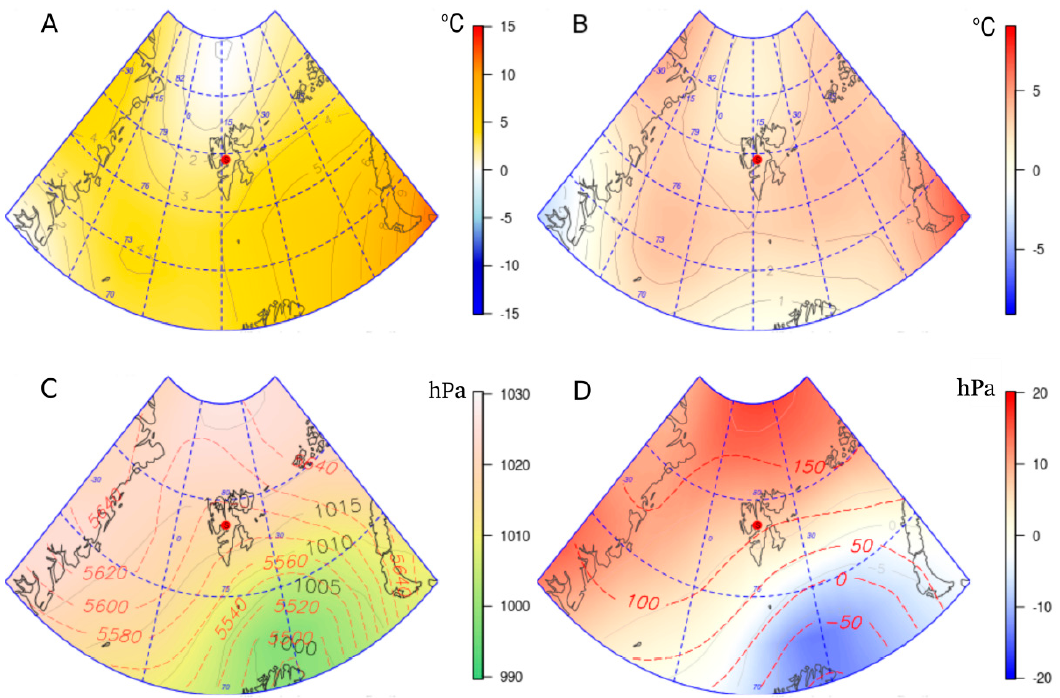
Figure 5. Air temperature at an altitude of 850 hPa (T850) (°C)—grey solid line ( A ) and its anomalies ( B ) and the daily sea-level pressure distribution (SLP) (hPa)—grey solid line and geopotential height of 500 hPa (m)—red dotted line ( C ) and its anomalies ( D ) for 10 July 2016. The red point shows the research area.